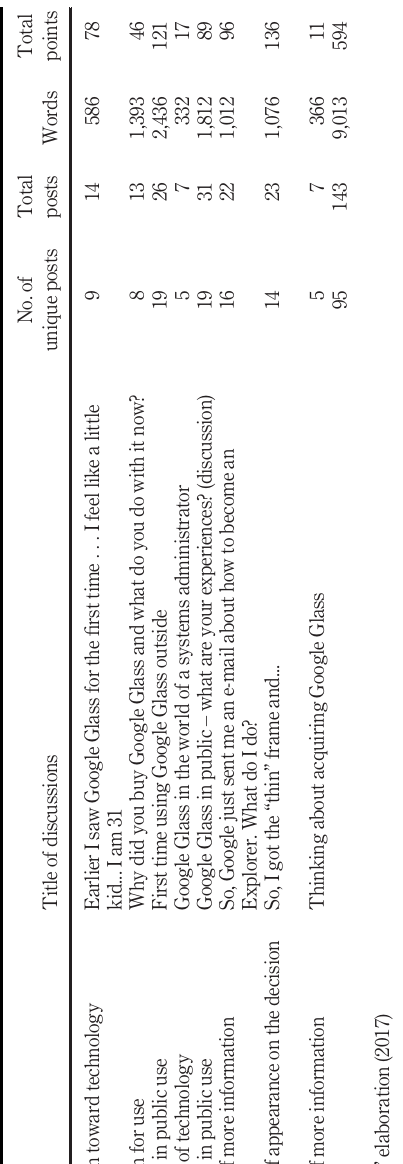
Table II. Topics identified, discussion titles and details on